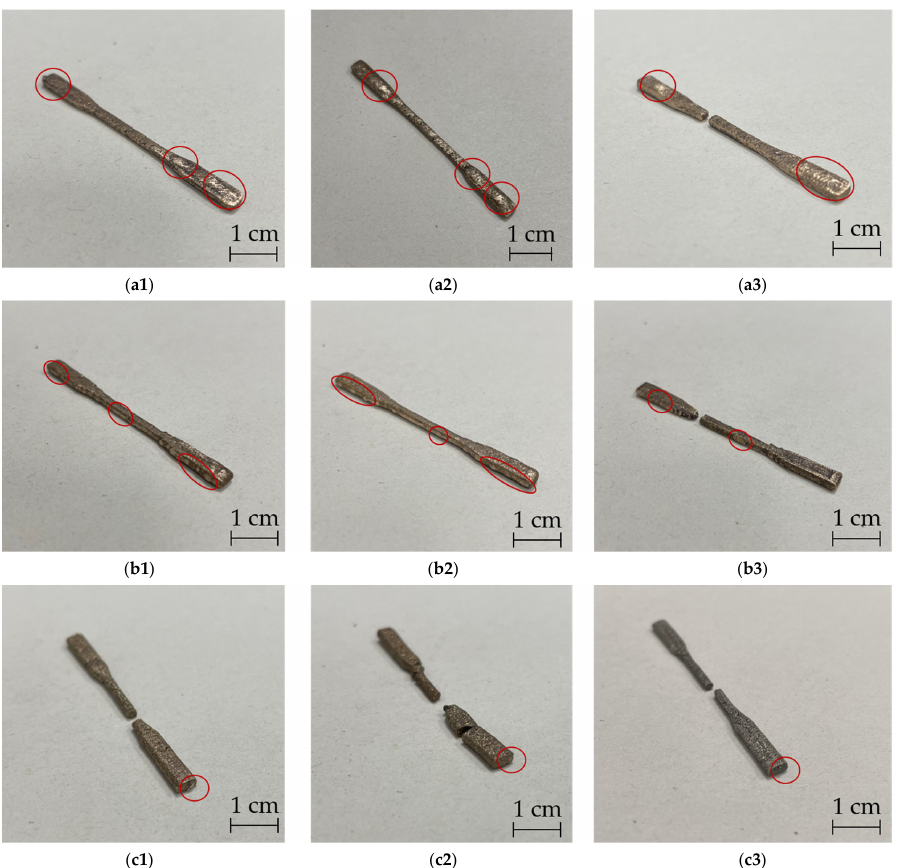
Figure 7. Results of pore position on metal tensile specimens from nine combinations between printing directions and sintering directions (the red circles represented the pores on surfaces of metal parts): ( a1 ) flat printing-flat sintering; ( a2 ) flat printing-on-edge sintering; ( a3 ) flat printing-upright sintering; ( b1 ) on-edge printing-flat sintering; ( b2 ) on-edge printing-on-edge sintering; ( b3 ) on-edge printing-upright sintering; ( c1 ) upright printing-flat sintering; ( c2 ) upright printing-on-edge sintering; ( c3 ) upright printing-upright sintering.